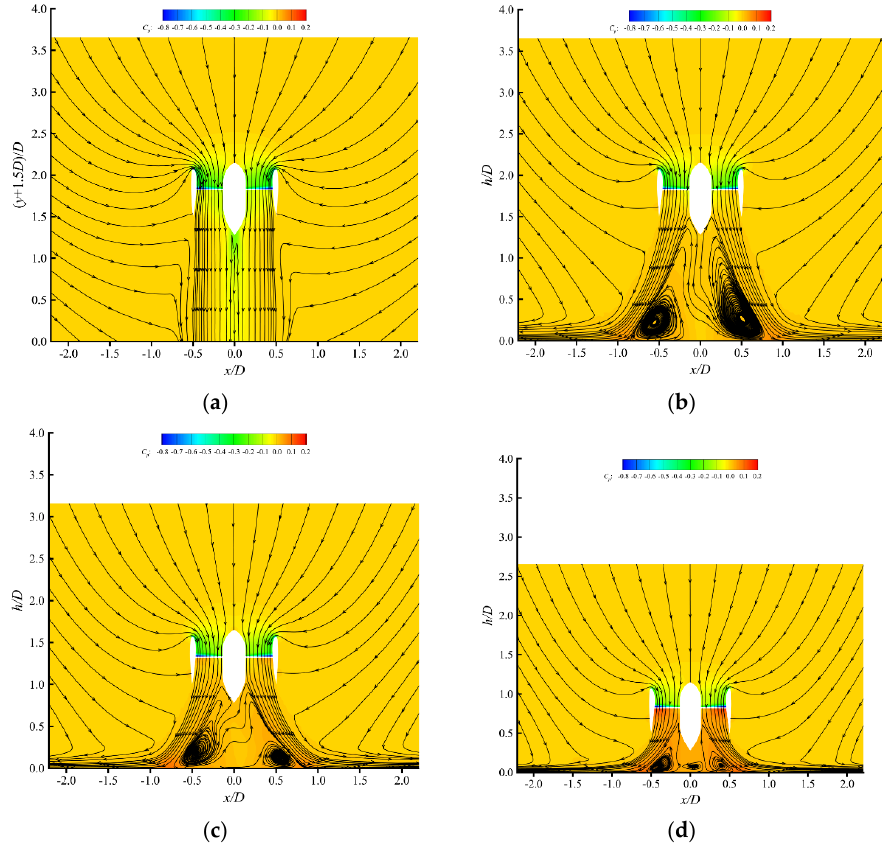
Figure 18. Pressure coefficient contour and streamlines on cross section at Ψ = 0°−180°: ( a ) OGE; ( b )